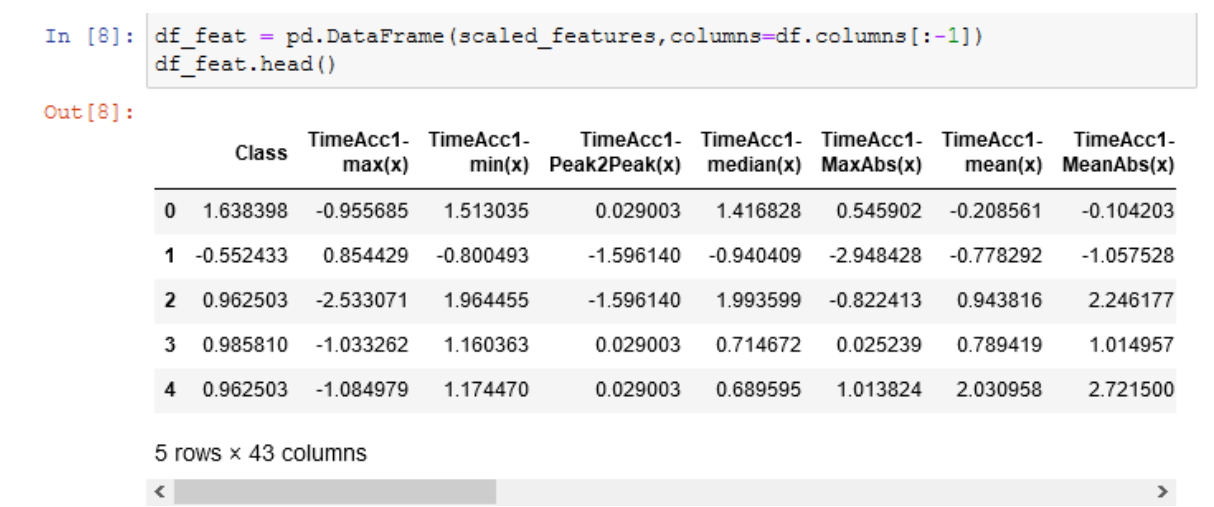
Figure 7. Results of the standardization step.